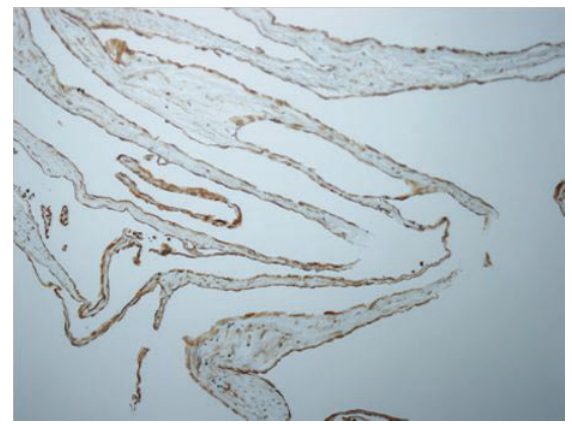
Figure 4. Immunohistochemical reaction positivity with podoplanin.